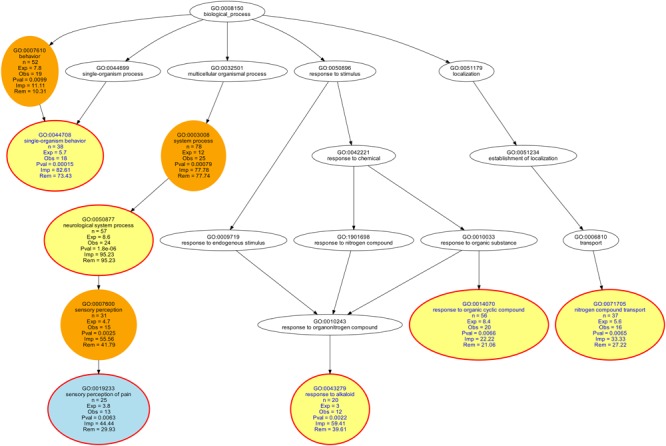
Top–down representation of the annotations (GO terms) representing the taxonomy of the functional differences between the set of d = 77 genes included in the proposed NGS panel of persisting pain and two alternative proposals of genes modulating persisting pain in humans (Mogil, 2012; Zorina-Lichtenwalter et al., 2016). The figure represents the results of an over-representation analysis of the present set of d = 77 genes against the reference comprising the set intersection of the alternative gene lists. A p-value threshold of 0.01 and Bonferroni α-correction were applied. Significant terms are shown as colored circles with the number of member genes, the number of expected genes by change and the significance of the deviation of the observed from the expected number of genes indicated (yellow = headline, red = significant term, blue = significant term located as a leave at the end of a taxonomy in the polyhierarchy). The graphical representation follows the standard of the GO knowledgebase, where GO terms are related to each other by “is-a,” “part-of,” and “regulates” relationships forming a polyhierarchy organized in a directed acyclic graph (DAG, Thulasiraman and Swamy, 1992). The figure has been created using our R library “dbtORA” (https://github.com/IME-TMP-FFM/dbtORA, Lippmann et al., 2018) on the R software package (version 3.4.2 for Linux; http://CRAN.R-project.org/, R Development Core Team, 2008) and the freely available graph visualization software GraphViz (http://www.graphviz.org, Gansner and North, 2000).